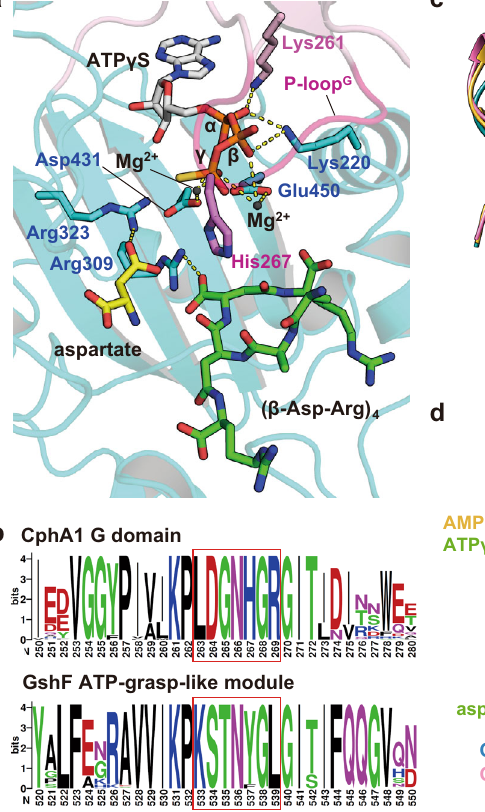
GshF from Pasteurella multocida . c Structural comparison of G lid among three states of Te CphA1. A comparison was performed after superposing the G core modules of the three states. Green spheres represent two Mg 2+ ions. Asterisks and red arrows indicate the position of Lys293 and the C-terminal backbone carboxy group of ( β -Asp-Arg) 4 , respectively. d Superposed structures using the G core modules of the substrate-bound Te CphA1 and the AMPPCP/( β -Asp-Arg) 8 -NH 2 - bound Su CphA1 structure (PDB 7LGJ) 13